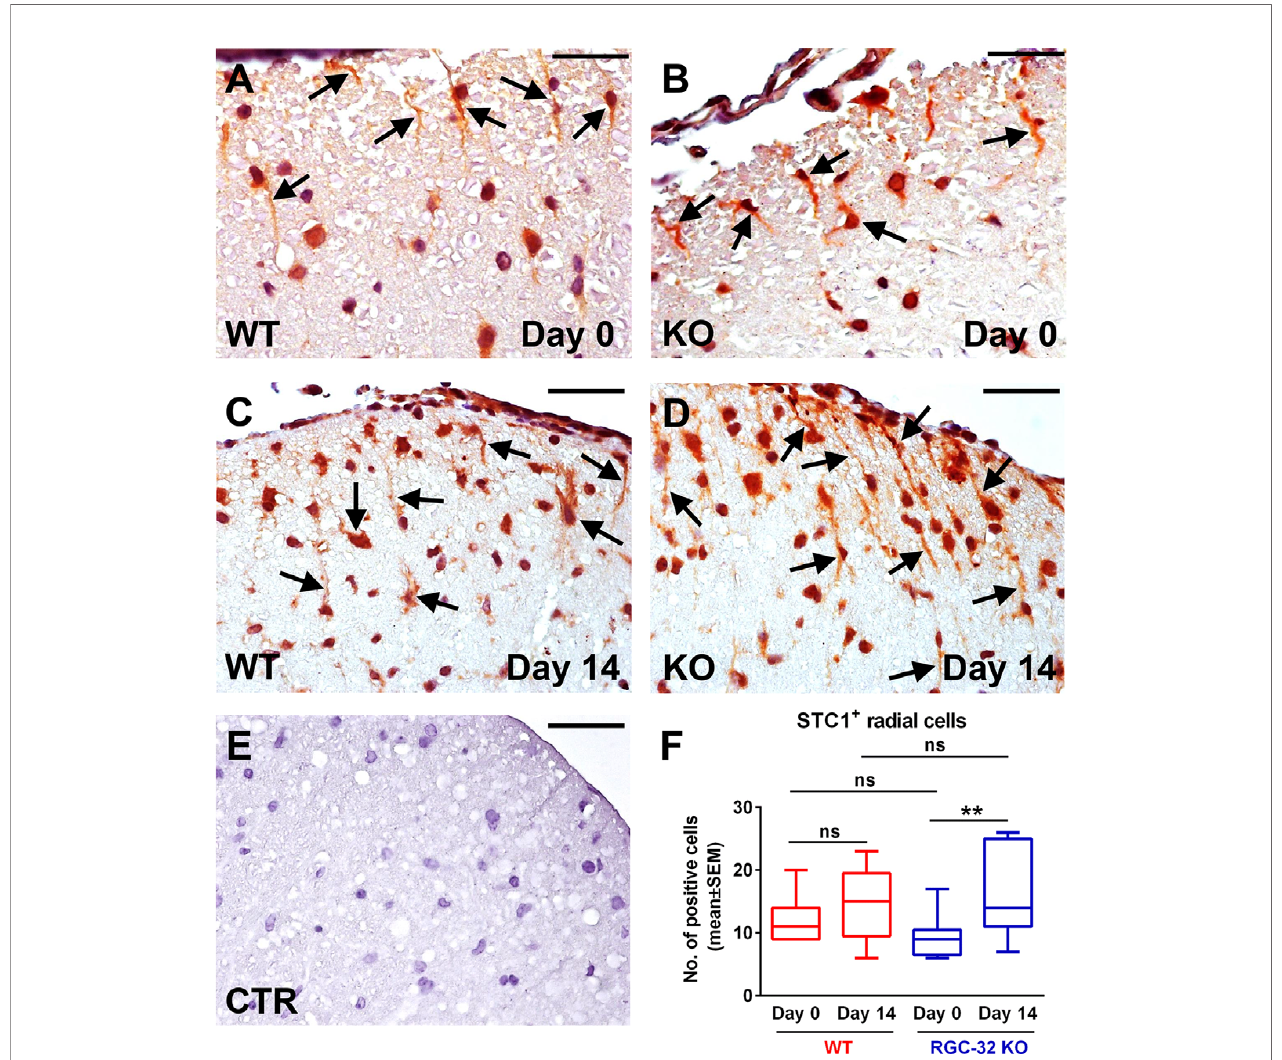
FIGURE 9 | Lack of RGC-32 affects the number and morphology of STC1 + spinal cord cells in vivo at the peak of EAE. Cervical spinal cords were harvested from control mice (day 0) and from mice with EAE on day 14, stained with an anti-STC1 antibody, and then counterstained with Harris hematoxylin. We observed STC1 + radial glial cells in both WT ( A , arrows; number of STC1 + cells detected: 8) and RGC-32 KO mice ( B , arrows; number of STC1 + cells detected: 7) on day 0. On day 14, STC1 + cells from RGC-32 KO mice displayed an increase in the length of their processes ( D arrows; number of STC1 + cells detected: 13), in contrast to WT mice, which showed little morphological change as compared to day 0 ( C arrows; number of STC1 + cells detected: 9). The control (CTR) for the immunoperoxidase reaction was negative (E) . Original magni fi cation: x40. Scale bars: 20 µm. STC1 + cells with radial morphology were manually counted in white matter areas corresponding to x20-magni fi ed spinal cord sections. Only RGC-32 KO spinal cords showed a statistically signi fi cant increase in the number of these cells on day 14 as compared to day 0 (F) . The results in (F) are expressed as mean ± SEM. Day 0: n = 3 mice (9 microscopic areas) in each group. Day 14: N = 4 mice (13 microscopic areas) in WT; N = 4 mice (11 microscopic areas) in RGC-32 KO. **p < 0.01; ns, not statistically signi fi cant (Kruskall-Wallis test with Dunn ’ s multiple comparisons